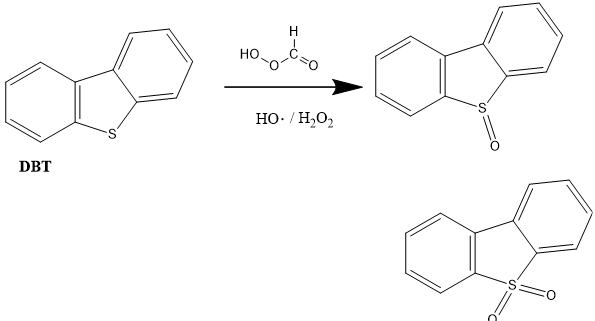
Figure 1: Mechanism of oxidation of sulphur-containing compounds